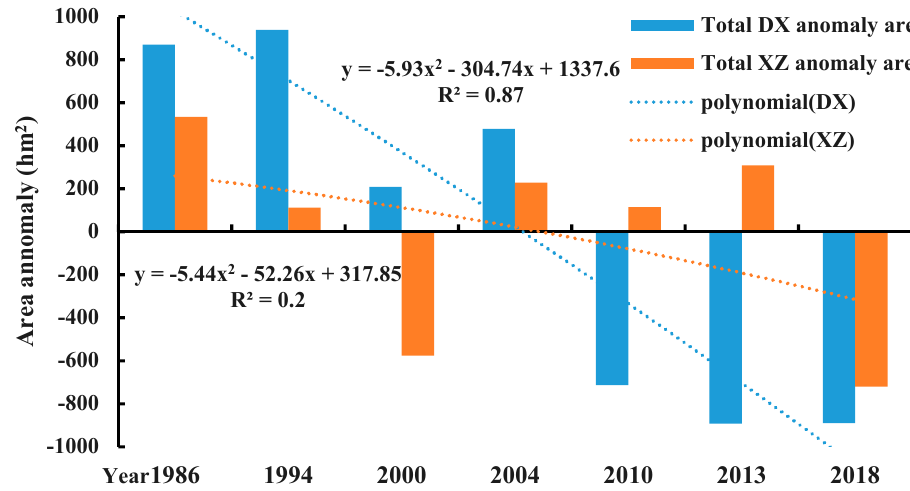
Figure 6. Channel bar area anomalies in the DX and XZ reaches.